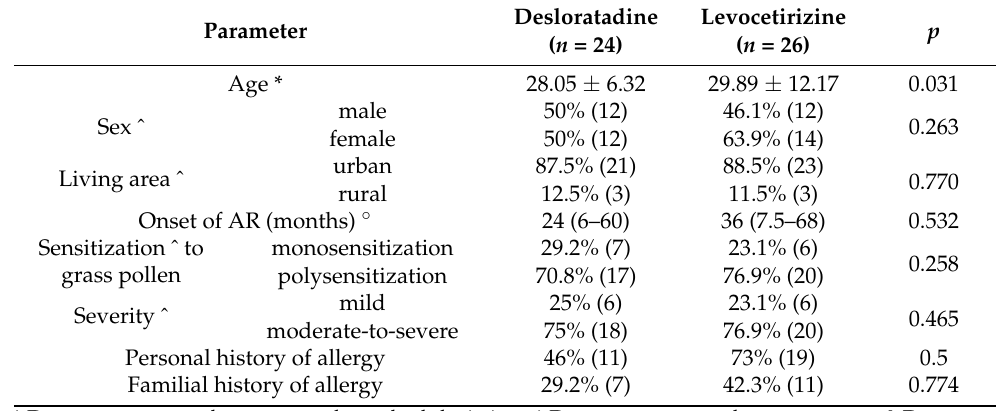
Table 1. Demographic